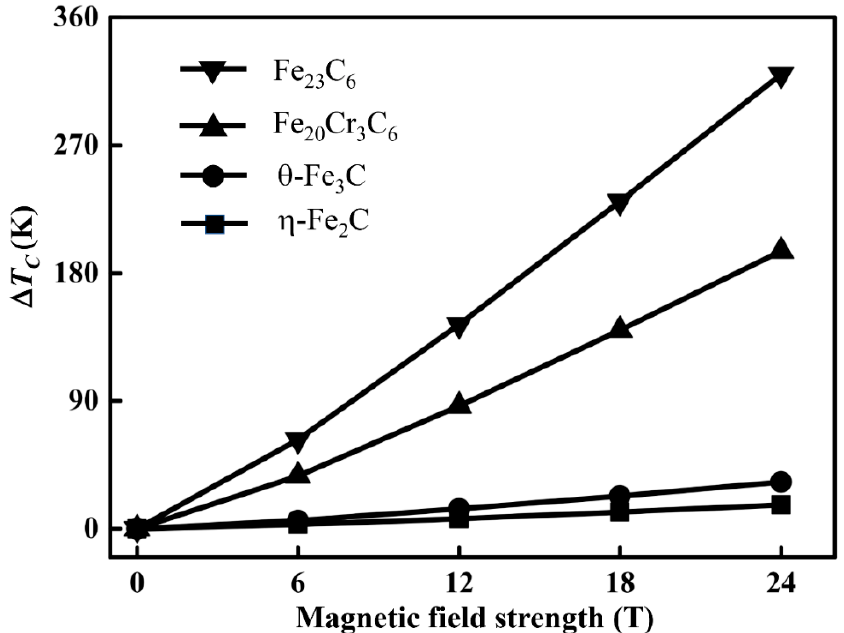
Figure 5. The change of Curie temperature ( ∆ T c ( B ) = T c ( B ) − T c ( 0 ) ) of carbides under various external magnetic fields.